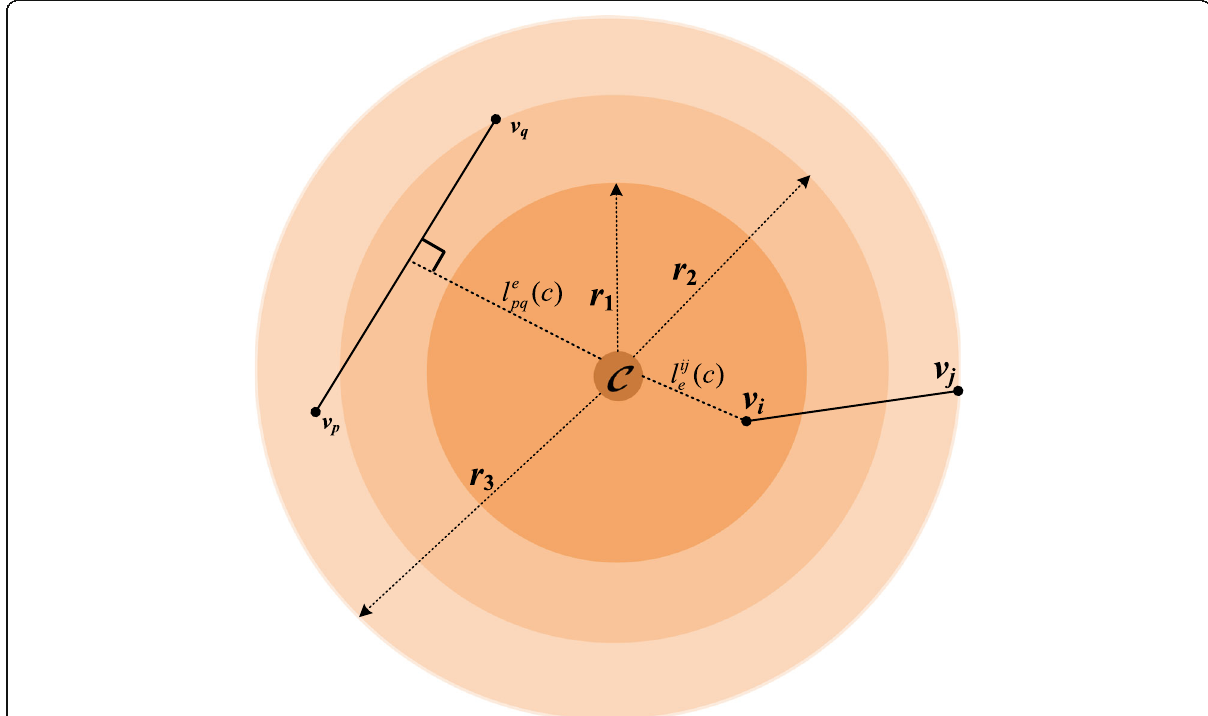
Fig. 3 Distance calculation for different links and an epicenter. This figure shows how to calculate the distance between the epicenter and links with different locations in the